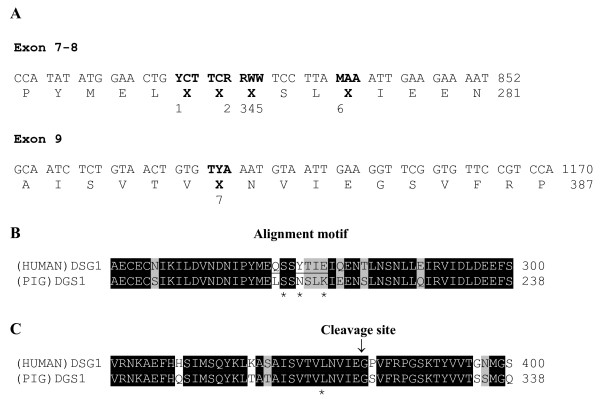
Amino acid changing polymorphisms in two areas of the porcine desmoglein 1 gene. A, Degenerate sequences of the porcine desmoglein 1 in the investigated regions showing part of the fragments amplified in the genotyping procedure. SNPs are marked with X. R: A or C, W: A or T, M: A or C, Y: C or T. B, Amino acid sequence alignment of human (HUMAN)DSG1 GenBank: AAC83817 and porcine (PIG)DSG1 GenBank: DQ823081 desmoglein 1 in the region around 110 amino acids upstream of the cleavage site. Underlined in the human sequence are the amino acids shown to be necessary for cleavage by exfoliative toxin ETA from S. aureus. Marked with asterisks * in the porcine sequence are the residues changed by single nucleotide polymorphisms found in this study. C, Alignment of (HUMAN)DSG1 and (PIG)DSG1 around the cleavage site (marked with arrow). Marked with asterisk * in the porcine sequence is the amino acid changed by single nucleotide polymorphism.